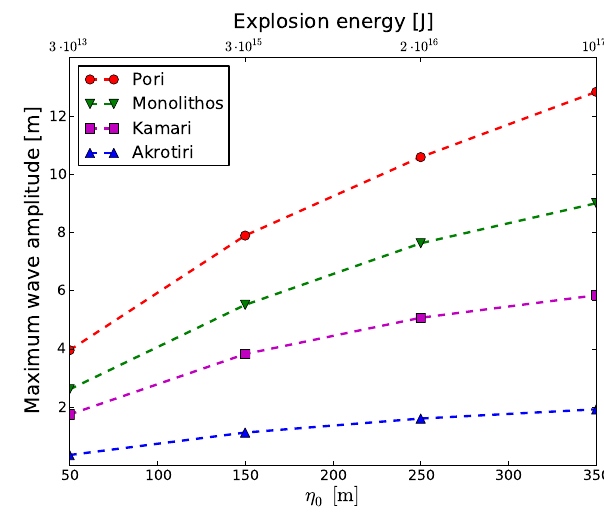
Fig. 11. Maximum wave amplitude A max as a function of explosion energy registered at four different locations on the east and south coasts of Santorini (cf. Fig. 2 for their